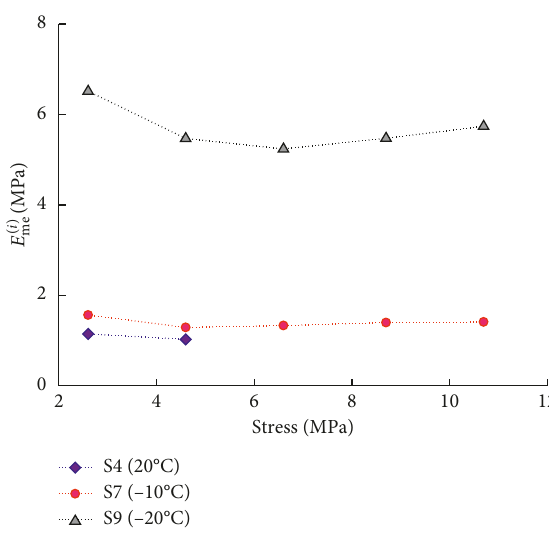
Figure 7: Instantaneous elastic modulus versus